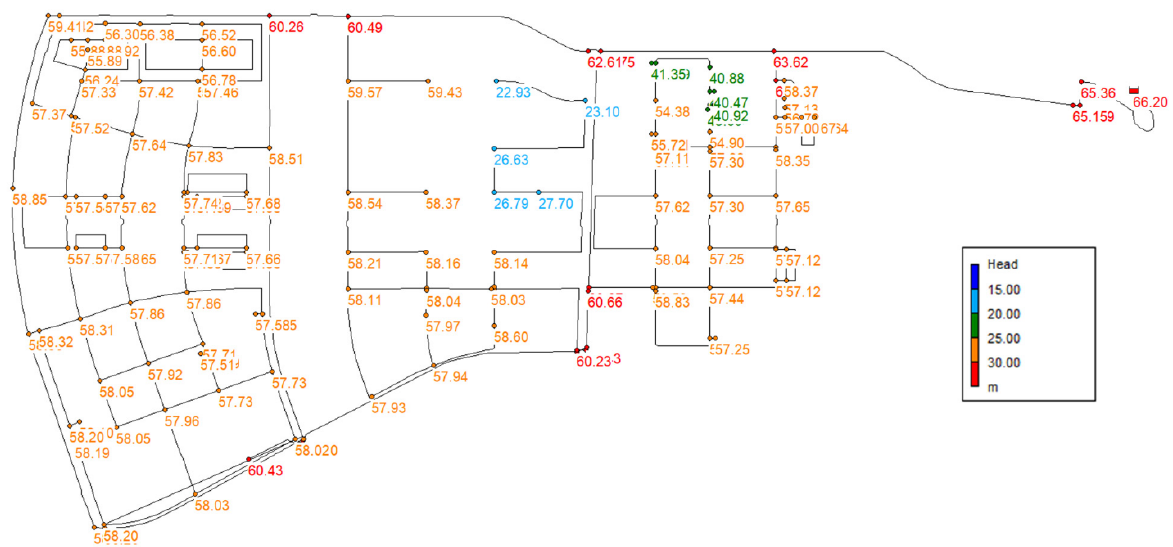
Figure 7. EPANET model of the Cheongna WDN, highlighting the head pressure in the nodes based on the optimal Hazen–Williams roughness coefficient C value distribution.